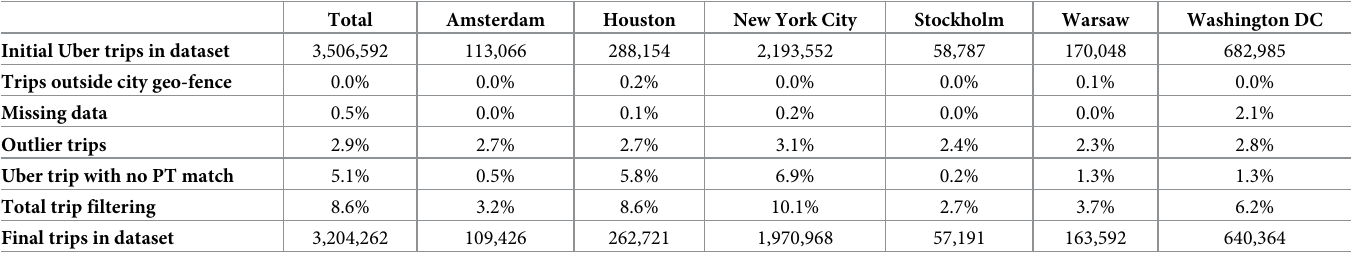
Table 1. Summary of data filtering